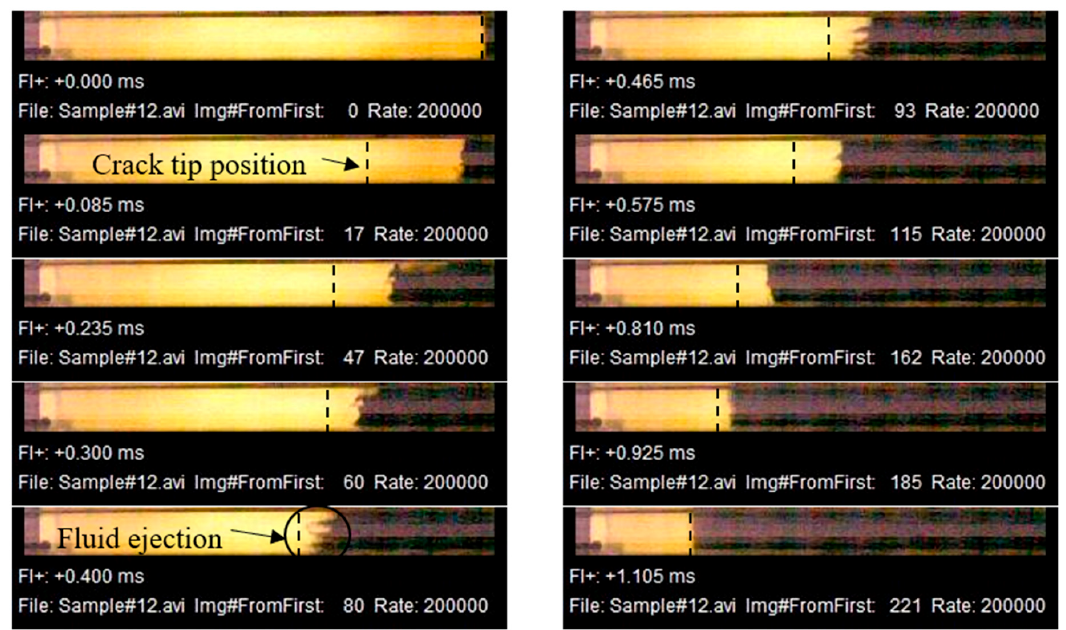
Figure 8. Dynamic images of the relationship between crack tip and fluid front of sample #12. The direction of the high-speed camera is shown in Figure 1a. The crack tip and the fluid front separate at the beginning of the propagation, and the fluid front catches up with the crack tip when it slows down. The phenomenon of fluid ejection presents when the fluid front approaches the crack tip, and meanwhile the fluid velocity is theoretically high but actually low in the real case.